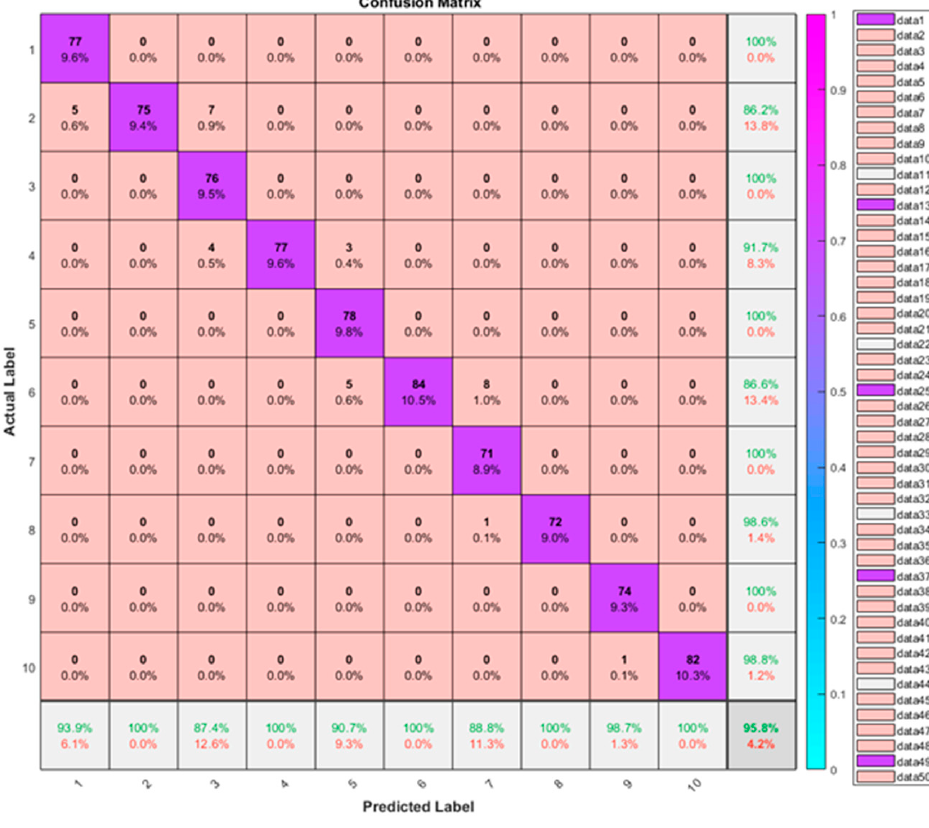
Figure 10. Confusion matrix results efficiency.